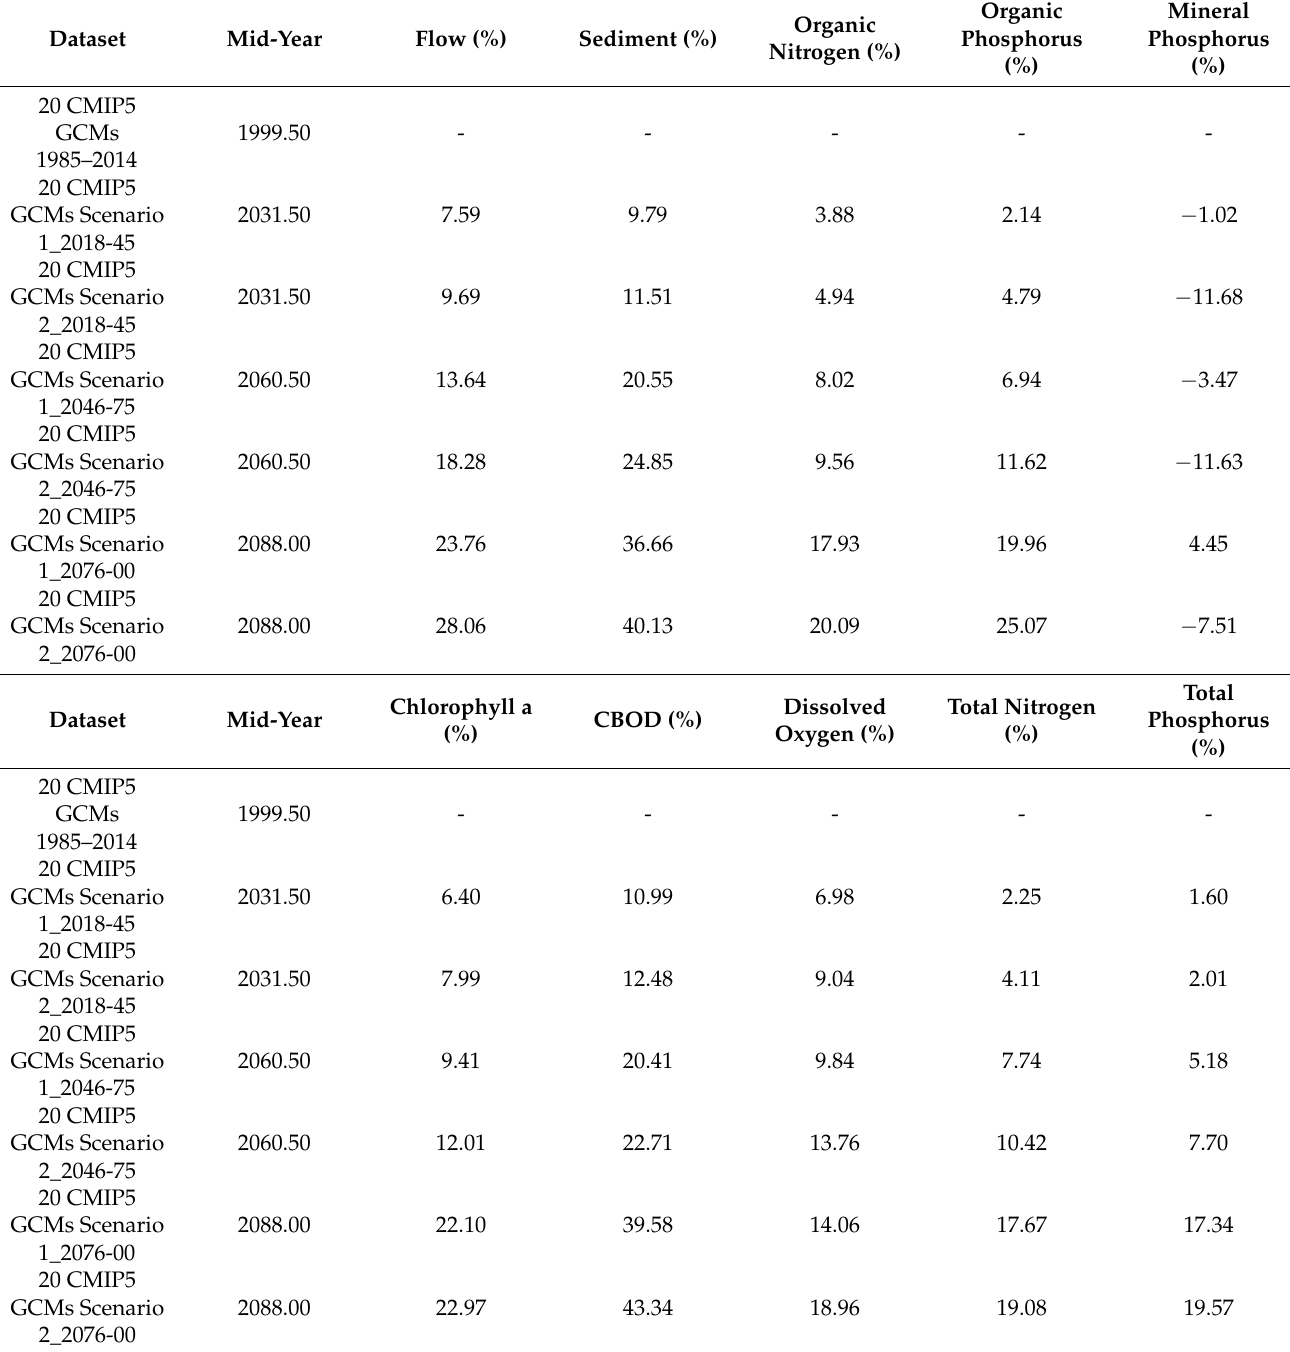
Table 6. Percentage change in the simulated variables relative to the historical climate window across the